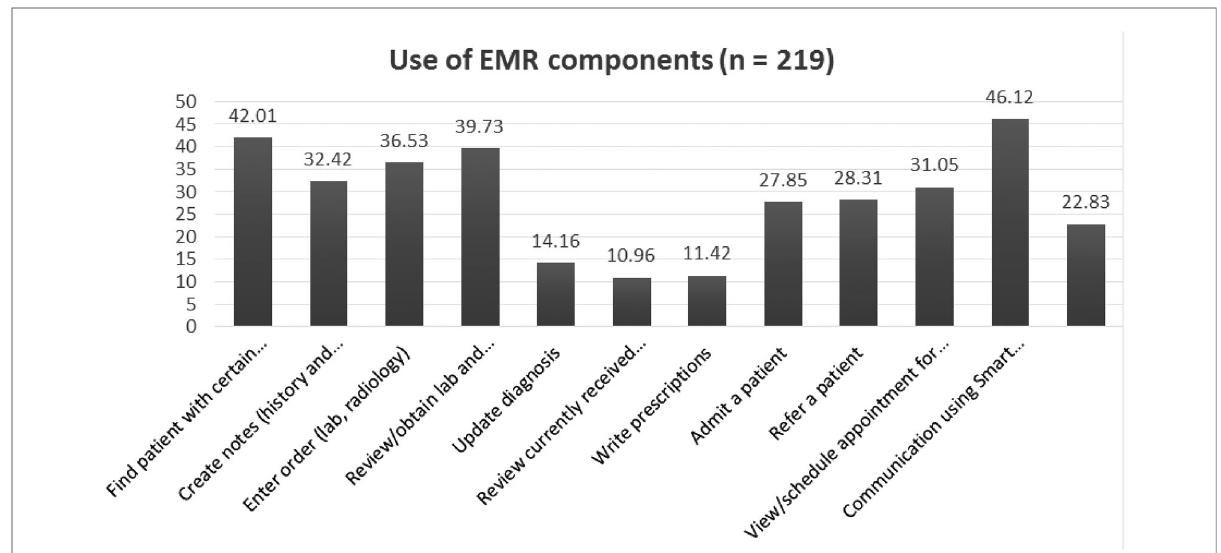
FIGURE 1 Use of the basic EMR components by health professionals, Dire Dawa, Ethiopia, 2019.